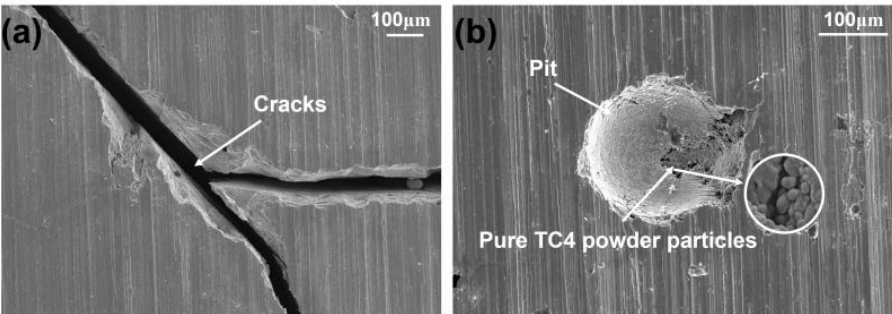
Figure 17. Surface topographies of laser clad coating (specimen No. 1). ( a ) Macro cracks; ( b ) Potholes and unmelted pure TC4 particles.